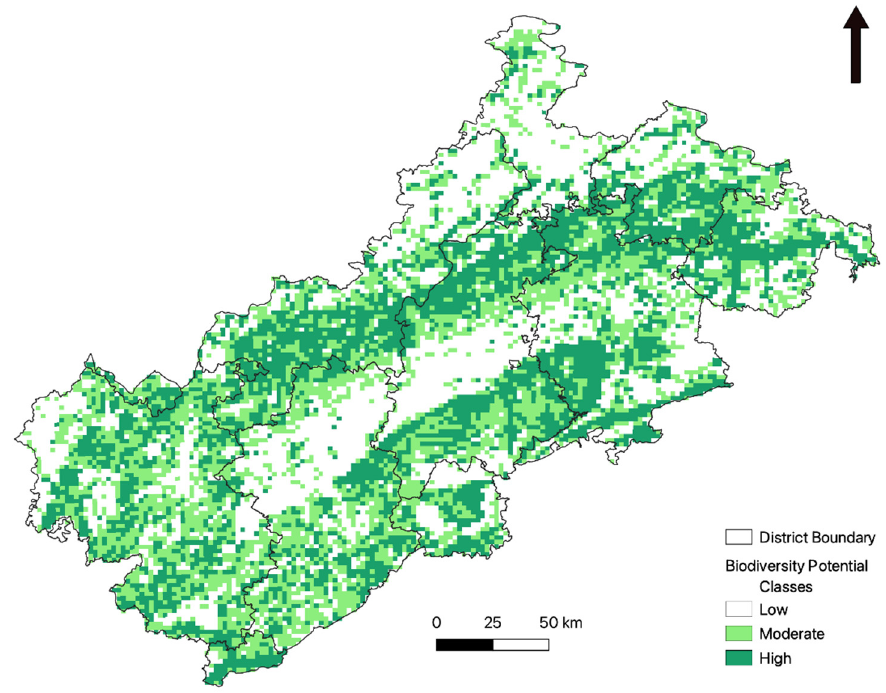
Figure 2. Spatial distribution of biodiversity potential classes in Panna Landscape. A total of 32 species of mammal and 355 species of vegetation were recorded during field sampling. Field measured species richness for different taxa was found to increase with the increase in biodiversity potential, except for herbivores, primates, and rodents, which have fewer species and are also present throughout the landscape. Kruskal–Wallis test using all taxa (data in Table 3) showed no statistically significant difference (chi- squared= 2.538, df=2, p= 0.281, 95% confidence interval) between the three biodiversity potential classes. However, a statistically significant difference (chi-squared=7.758, df = 2, p-value = 0.021) was noted if the species richness for herbivores, primates, and rodents was removed. Table 3. Field measured species richness in biodiversity potential classes. Field Measured Species Richness